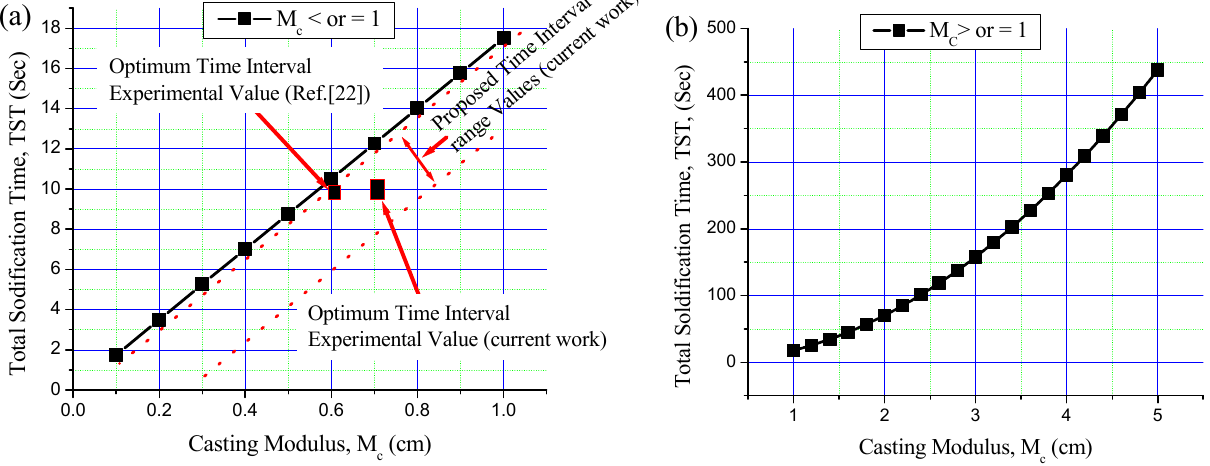
Figure 8. Total solidification time (TST) of Al-7.5Si alloy in metallic mould for castings with different casting moduli: ( a ) M c ≤ 1 and ( b ) M c ≥ 1. Areas between the two red dotted lines represent the proposed time interval range values.